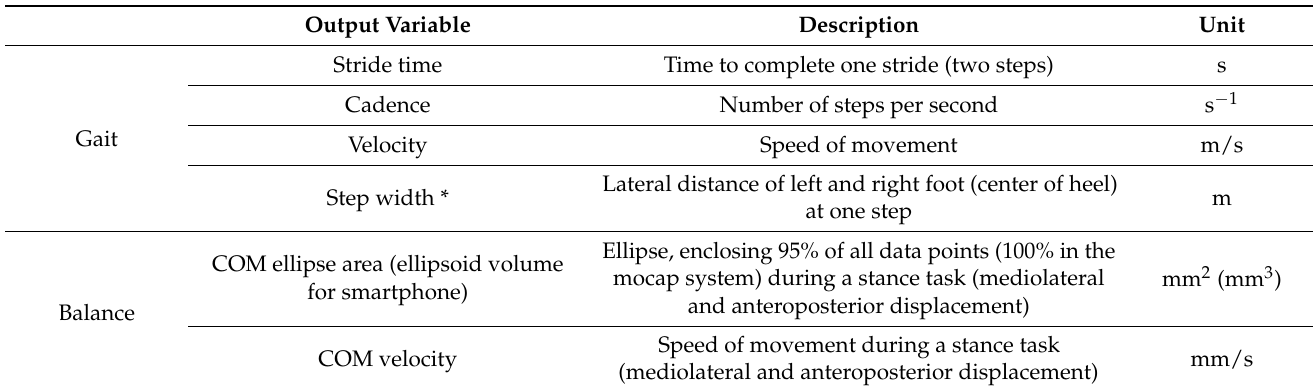
Table 2. Overview of gait and balance variables of all gait analysis systems used for statistical